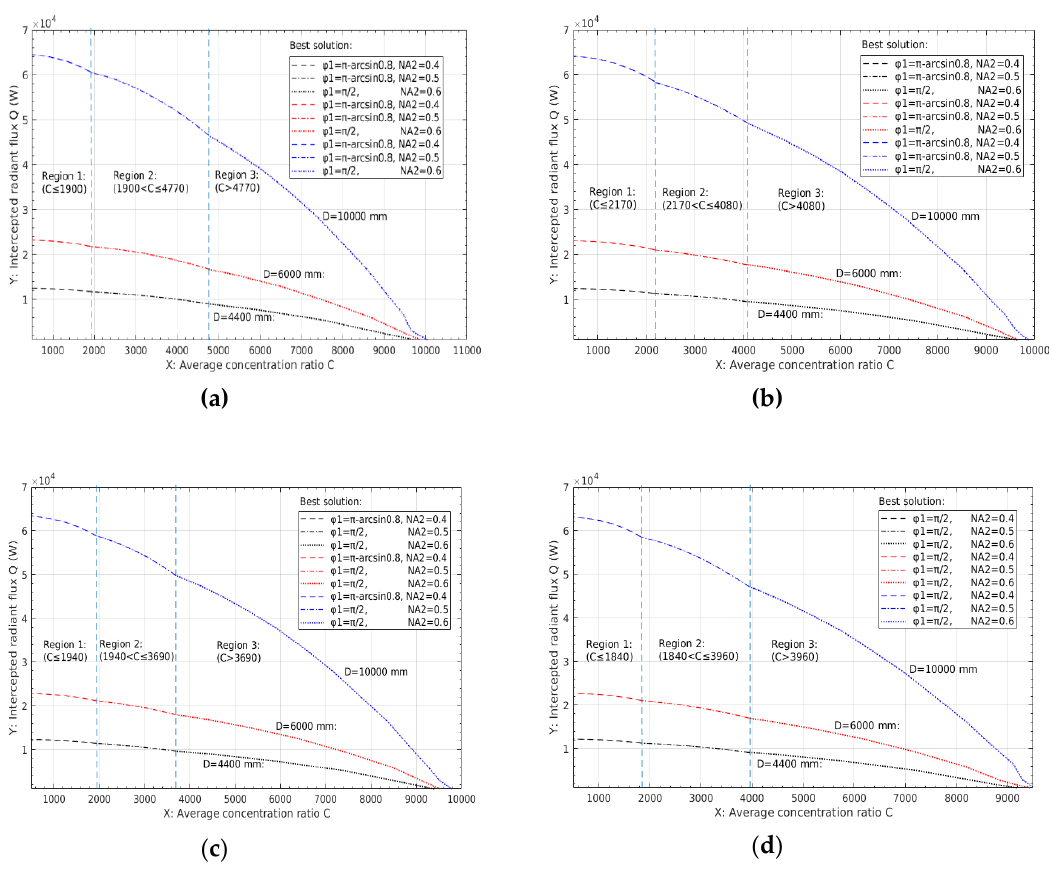
Figure 11. Results of intercepted radiant flux ( Q ) vs. variable of average concentration ratio ( C ) based on the best solutions in scales of D = 4400, 6000, 10,000 mms when θ inc = ( a ) 0.05, ( b ) 0.1, ( c ) 0.15, and ( d ) 0.2 rads.